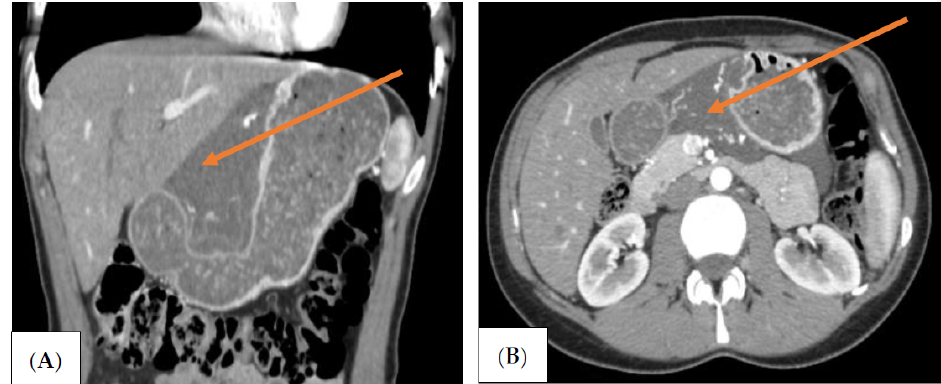
Figure 1. ( A , B ) Computed tomography (CT) image of the abdominal cavity. There is a visible mass located at the lesser curvature of the stomach (orange arrows).